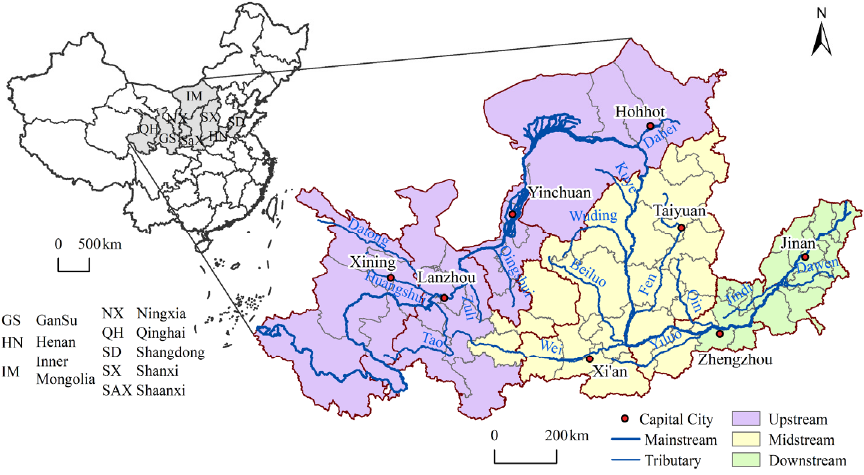
Figure 1. Study area of the Yellow River Basin.